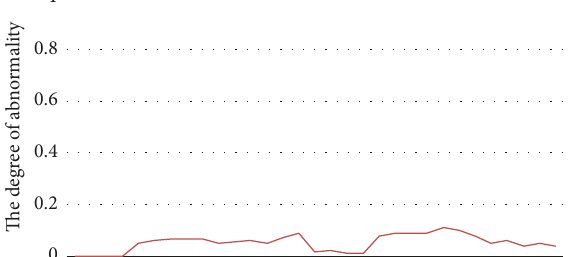
Table 2: Frequent abnormal data mining performance.